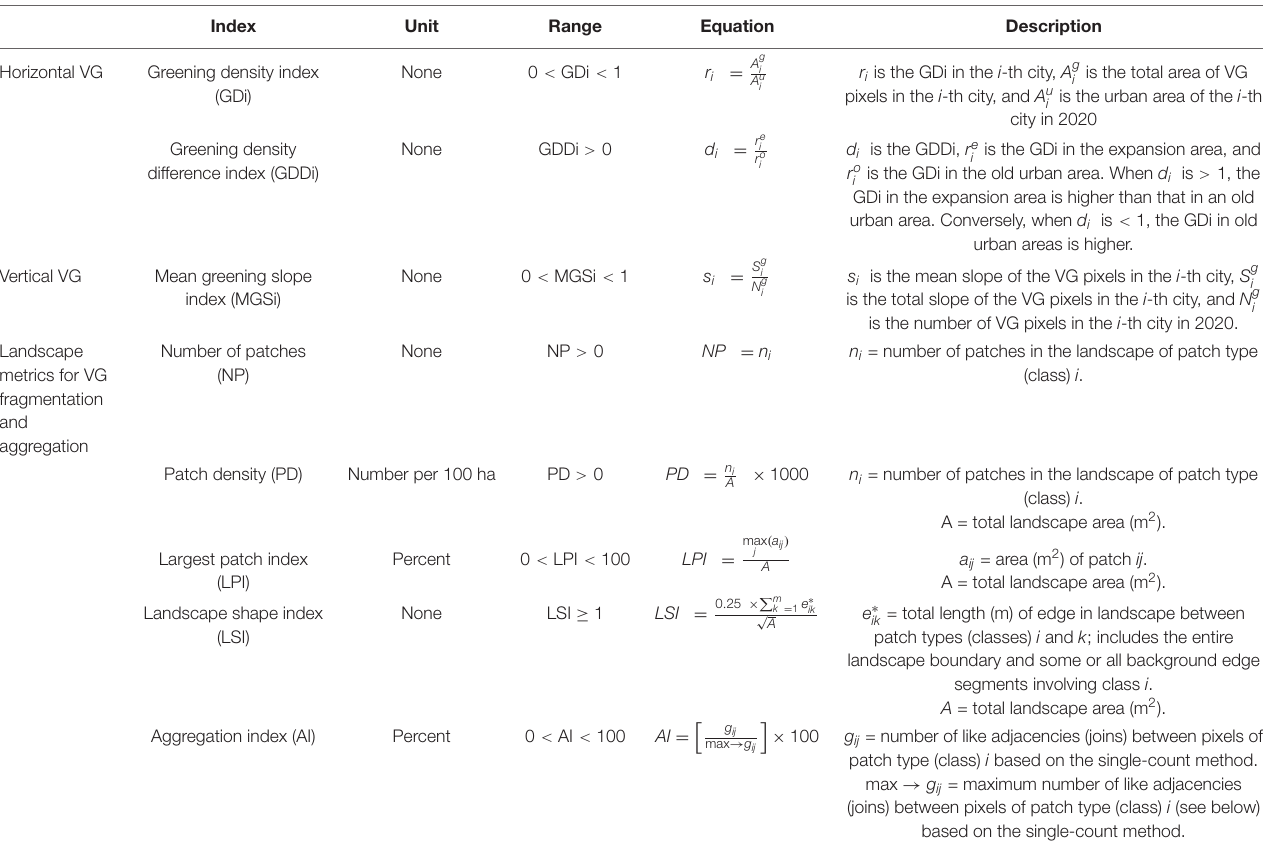
TABLE 1 | Descriptions of VG-related indexes used in this